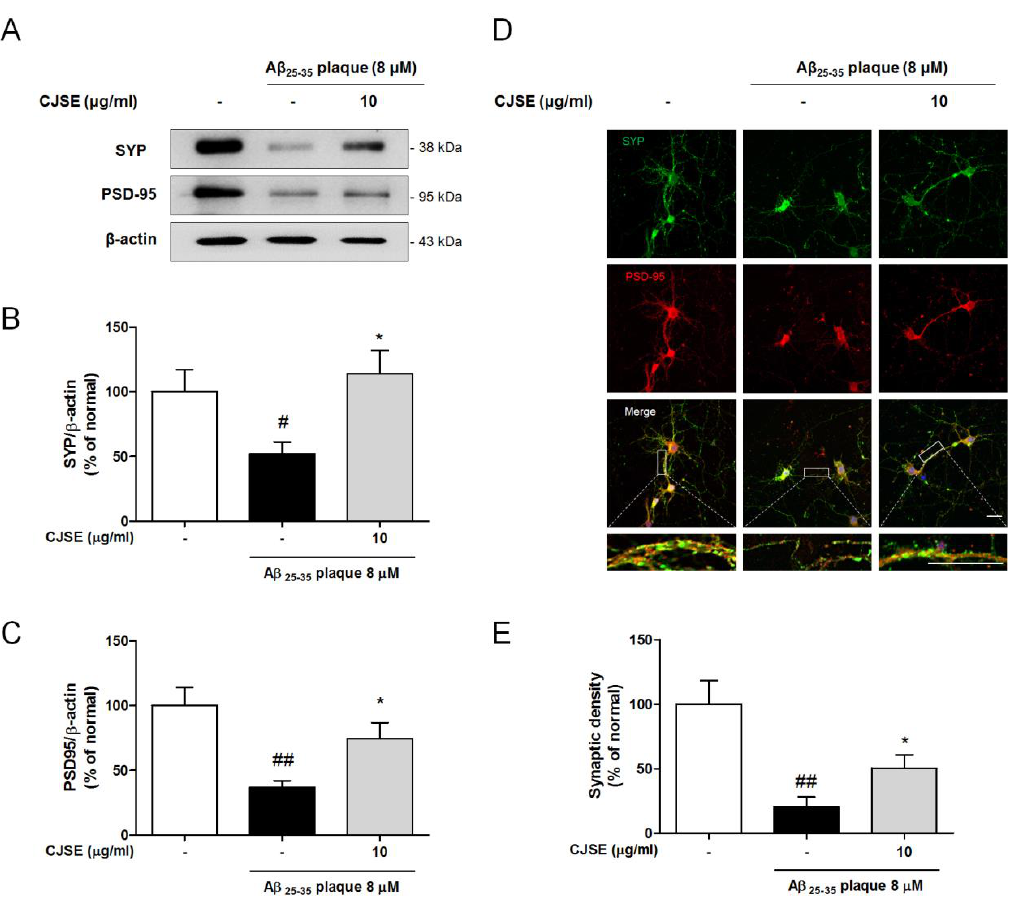
Figure 3. E ff ects of CJSE on loss of synaptic protein and functional synaptic density in mouse primary neuronal culture. ( A ) Representative band images of SYP and PSD-95 expression. ( B , C ) Quantifications of SYP ( B ) and PSD-95 ( C ) levels were normalized to β -actin. ( D ) Representative photomicrographs of SYP (green) and PSD-95 (red)-stained neurons. Bottom insets show higher magnification; scale bar = 100 µ m. ( E ) Quantifications of synaptic density (co-localized puncta of SYP and PSD-95). Values are indicated as the mean ± S.E.M. # p < 0.05 and ## p < 0.01 compared to the normal group; * p < 0.05 compared to A β -treated group.